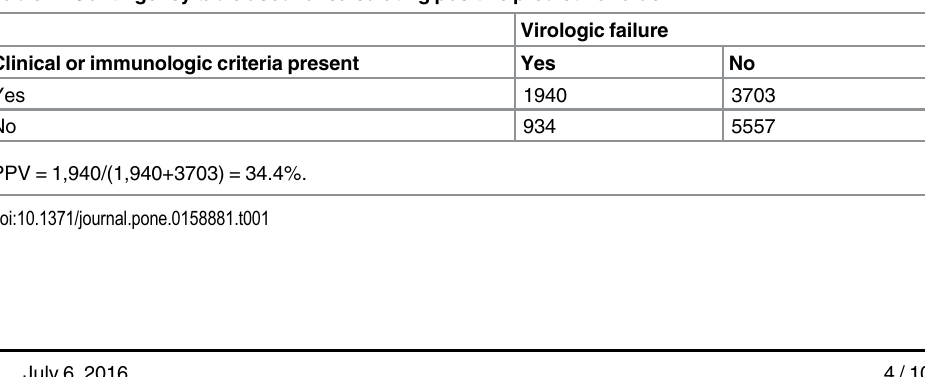
Table 1. Contingency table used for calculating positive predictive